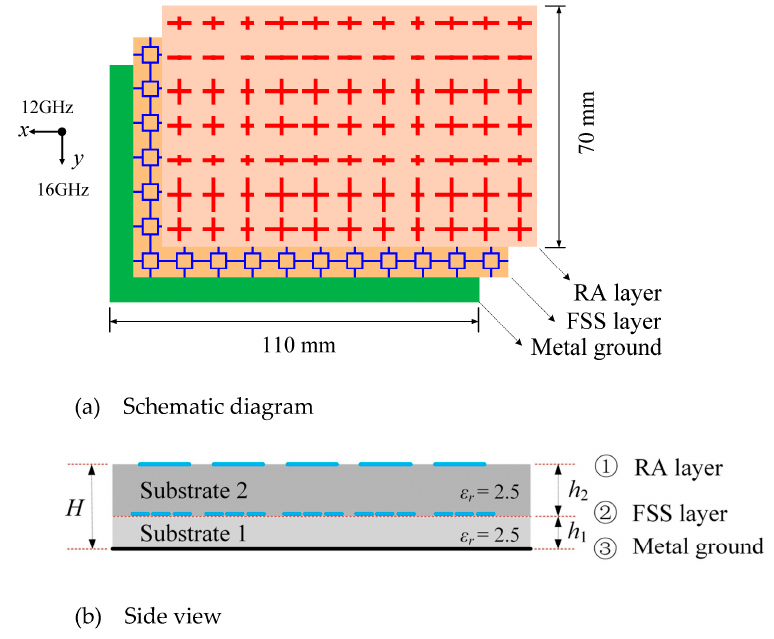
Figure 2. Schematic diagram and side view of the FSS sandwiched reflectarray.